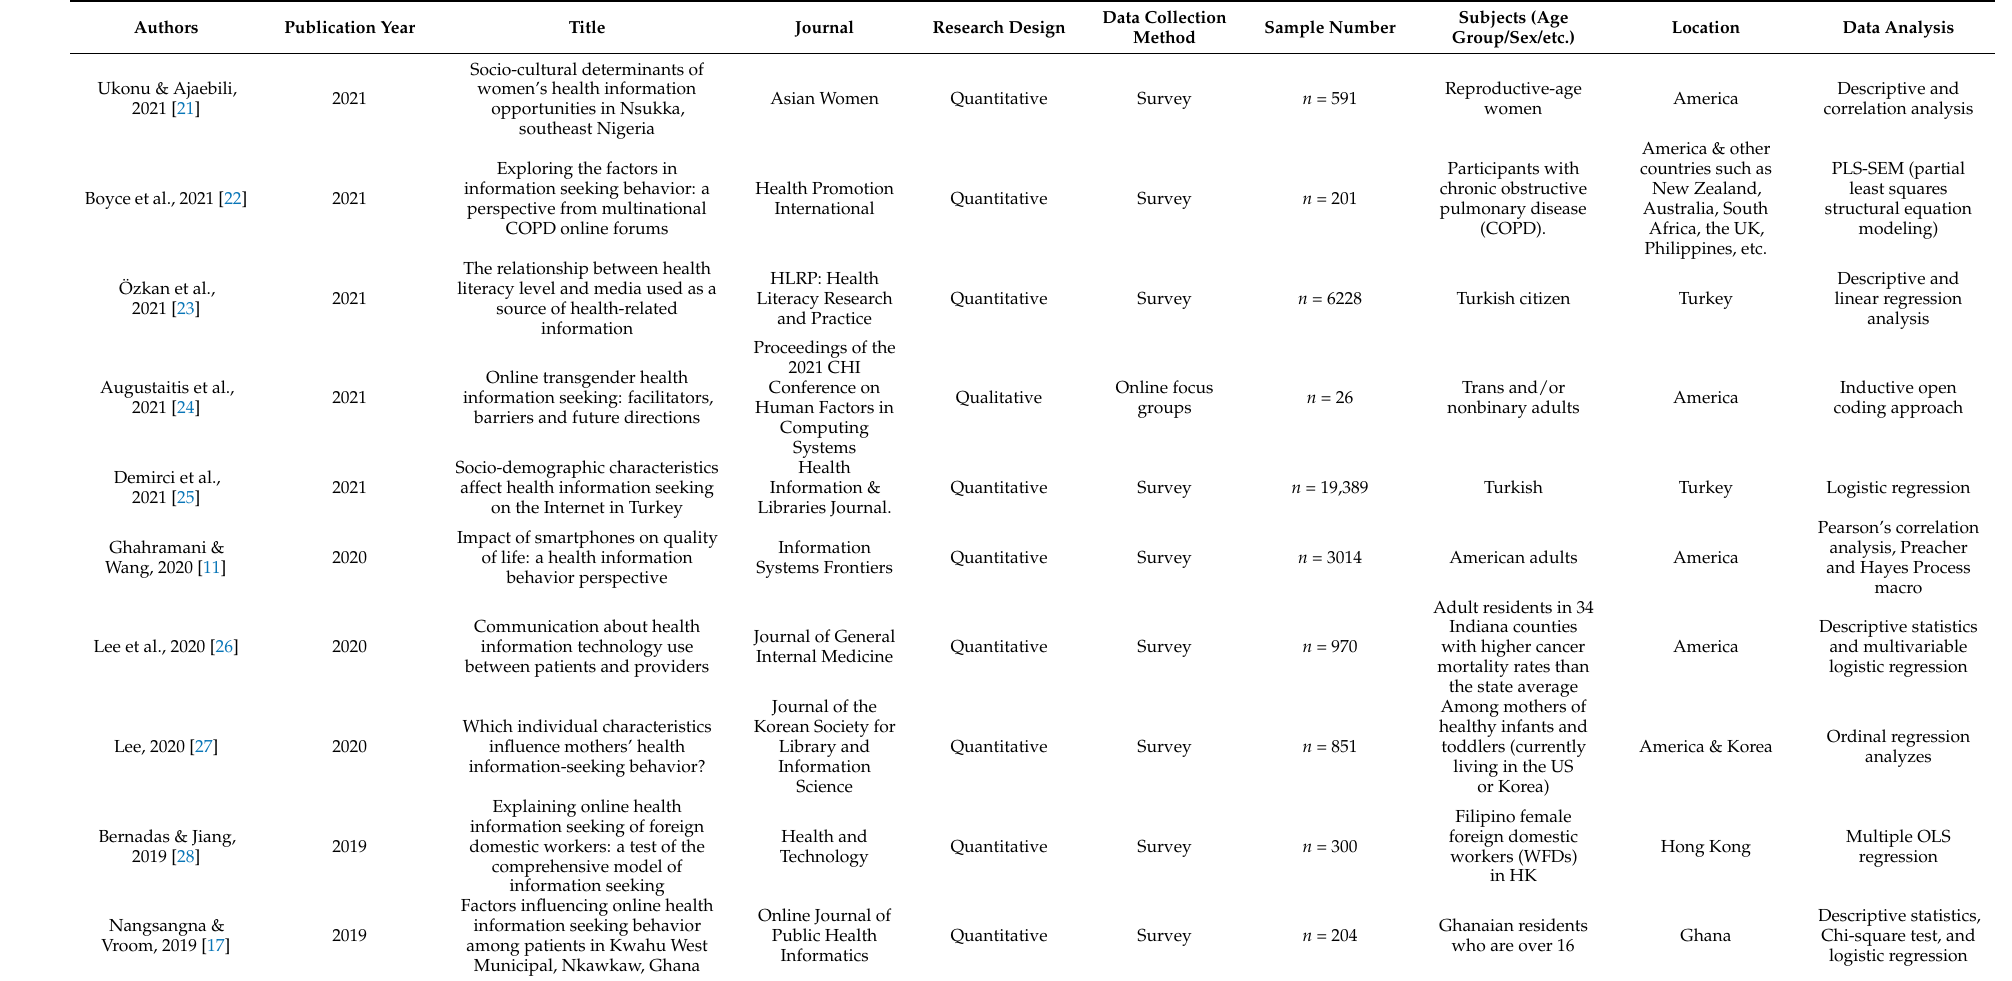
Table 1. The details of the articles